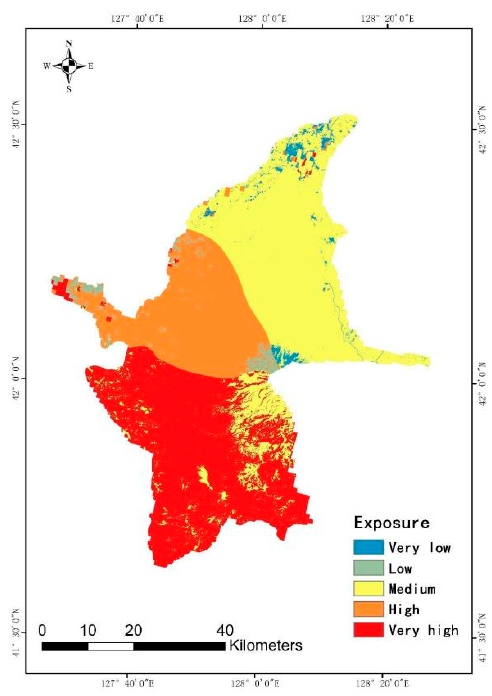
Figure 8. Earthquake landslide disaster exposure maps.